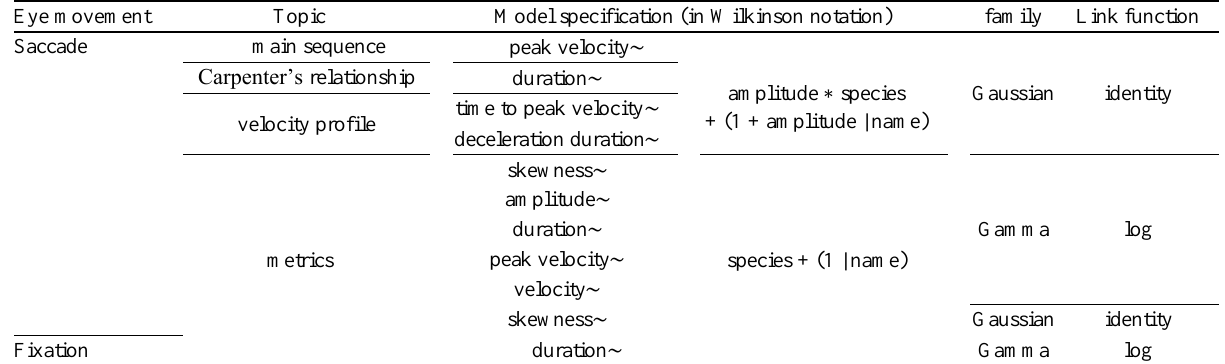
Statistical models tested in the